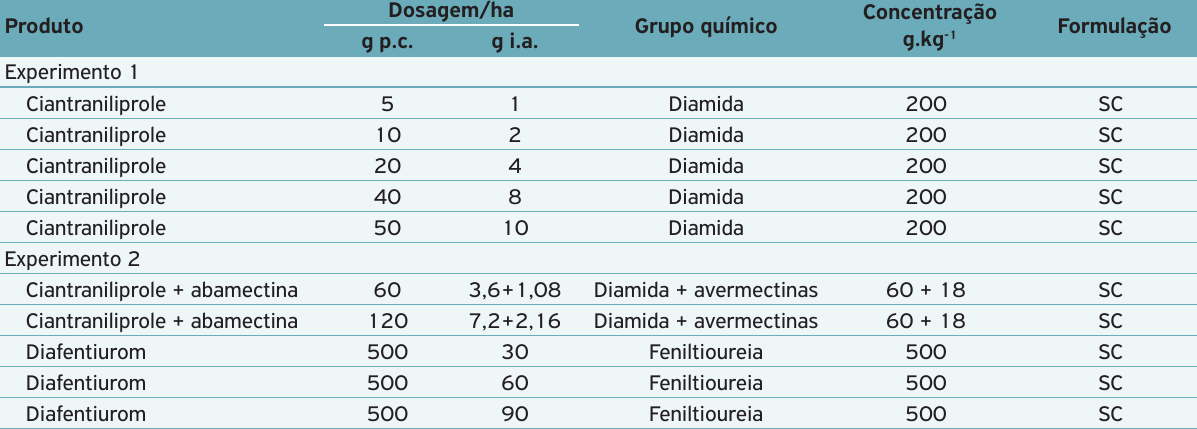
Tabela 2. Produtos químicos, dosagens, grupos químicos, concentrações e formulações utilizados nos experimentos 1 e 2 na cultura do pimentão ( Capsicum annuum L .